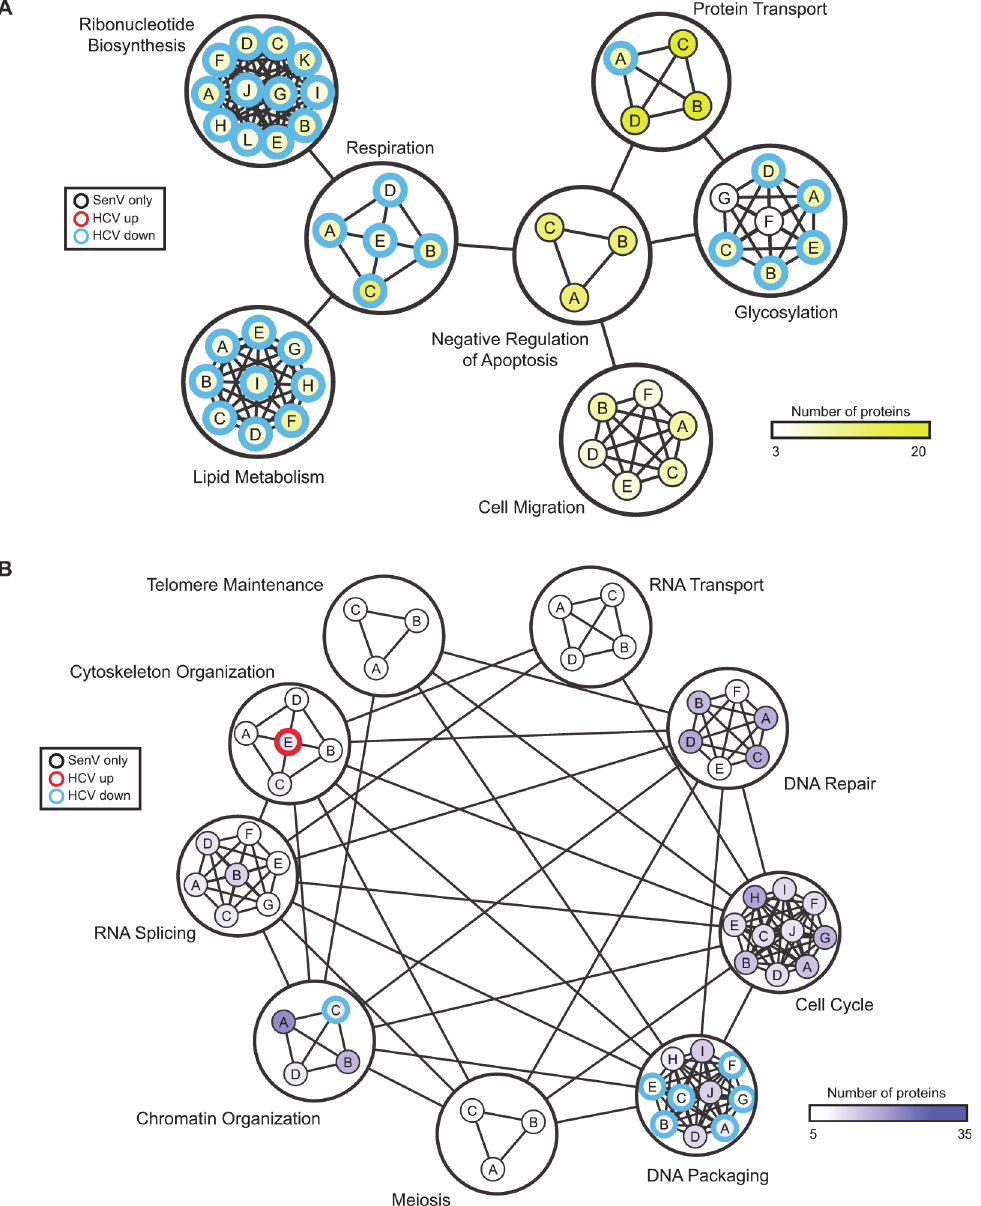
Fig 4. Network enrichment map of protein dynamics on the MAM during RNA virus replication. Enrichment map for proteins moving into the MAM with SenV (A) or leaving the MAM with SenV (B), compared to the proteins identified on the MAM during HCV. Nodes represent enriched biological pathways grouped by DAVID-identified clusters, manually circled and classified by function, for proteins differentially expressed in the MAM fraction following SenV ( (cid:1) 2-fold; BH-adjusted p-value < 0.05). Nodes were classified by Functional Annotation Clustering of Gene Ontology (GO) biological pathways using the DAVID bioinformatics resource. Edges between nodes represent overlap between two pathways, and edges between functional category clusters represent at least one shared protein. Node internal color is proportional to the number of proteins comprising the canonical pathway (darker shading in the node means greater number of proteins). Node edges in red represent pathways enriched in the MAM in cells replicating HCV and SenV, and node edges in blue represent pathways enriched in groups of proteins leaving the MAM in cells replicating HCV and SenV. Nodes edges in black represent SenV-specific changes. Node identity is depicted by the letter within each node, and the key is listed in S4 Table.